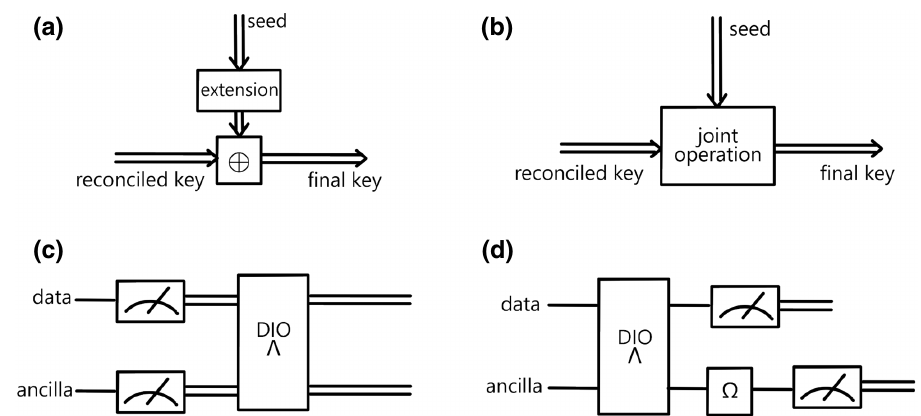
FIG. 4. (a) A schematic diagram for stream privacy amplification. The process of extending the seed can be treated as a pseudoran- dom number generator in step (2) of Table III. (b) The generalization of the extension and XOR operations as a joint operation, which can be seen as a classical encryption box. (c) The quantum form of (b). The classical joint operation becomes a DIO (cid:10) . (d) Changing the order of (cid:10) and measurement. The final measurement on ancillary qubits can be arbitrary with an extra operation (cid:11) .